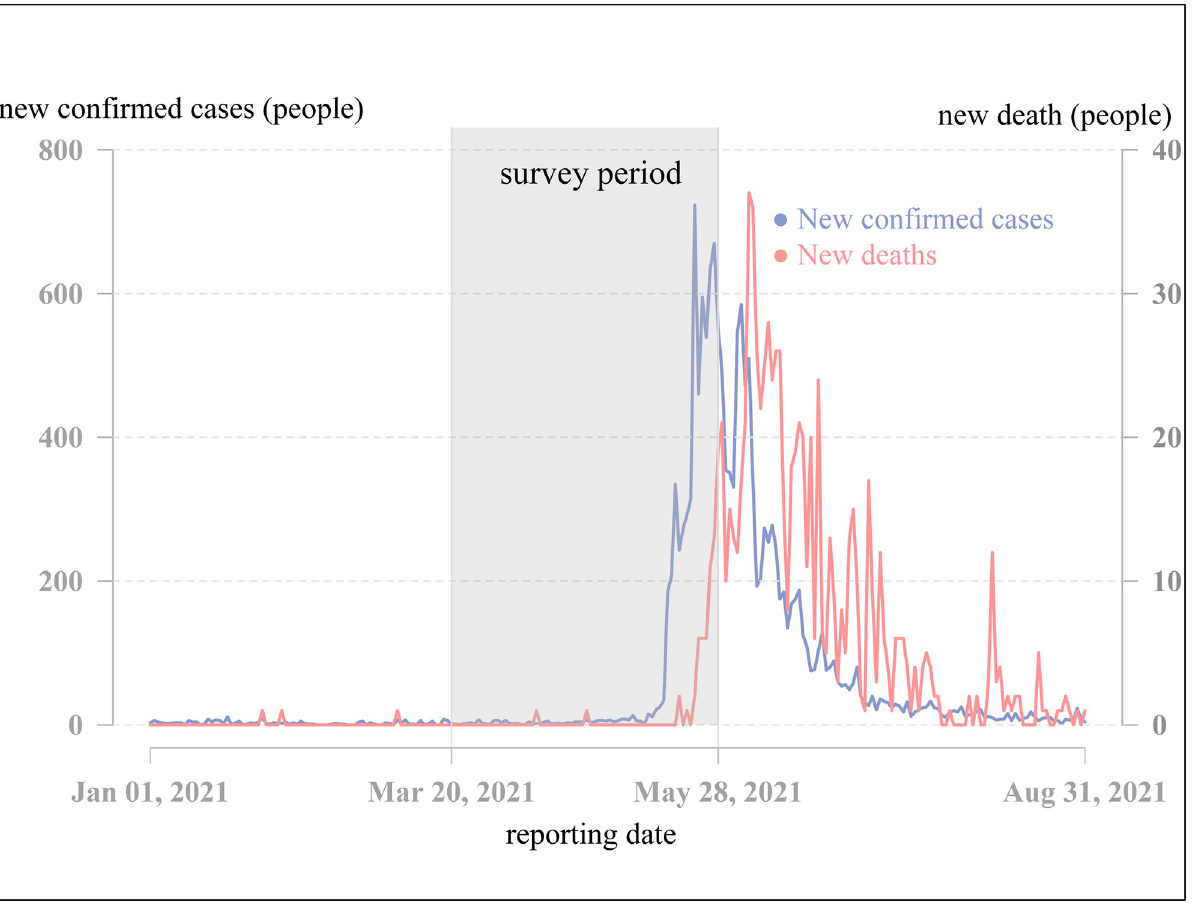
Fig 1. The timeline and casualties of Taiwan’s mid-2021 COVID-19 outbreak and our survey period.